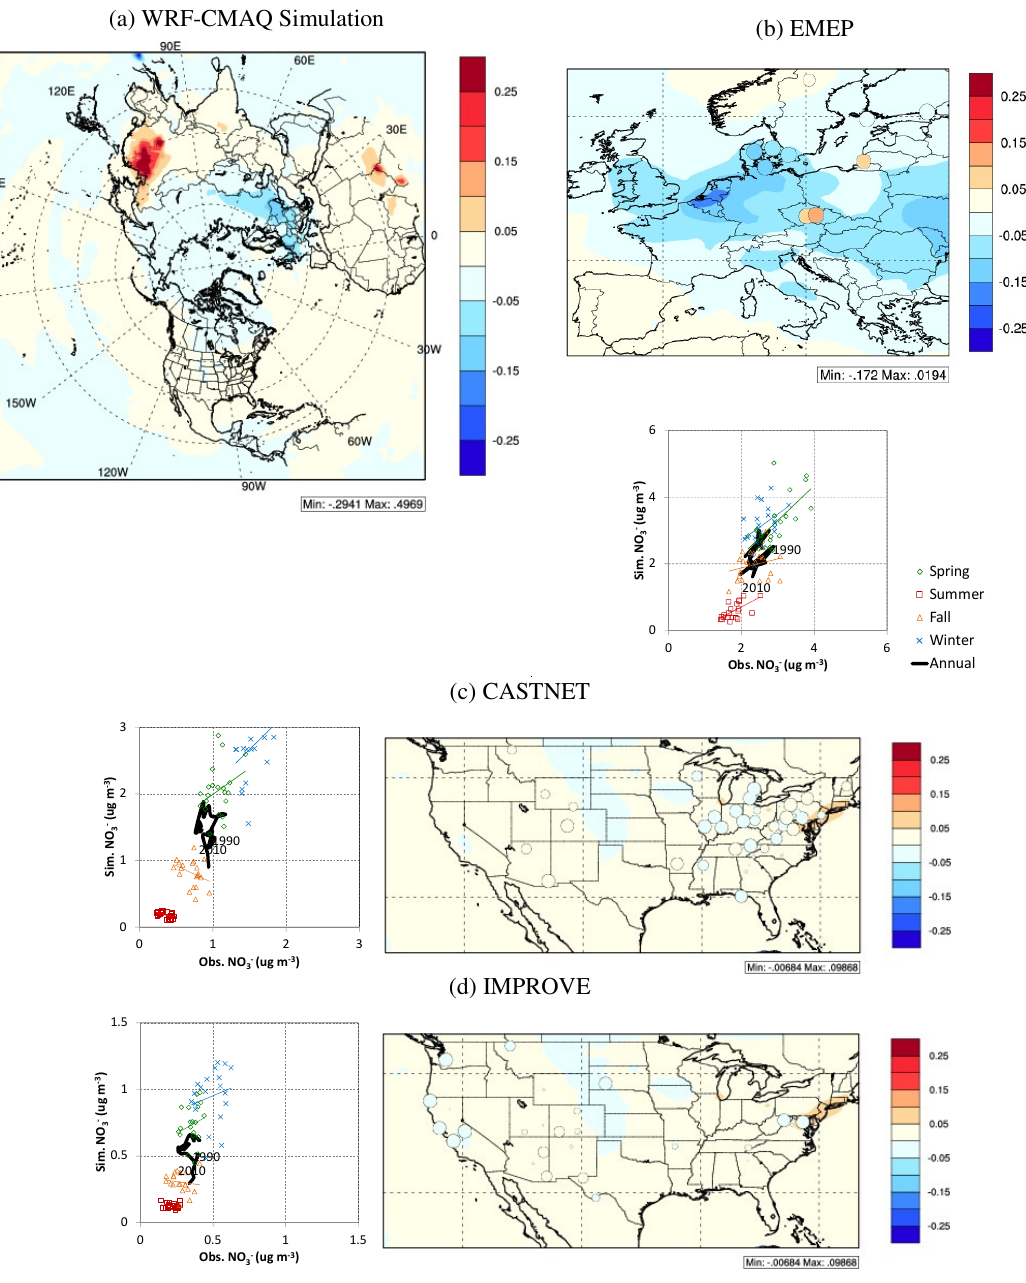
Figure 7. Same as Fig. 3 for NO −